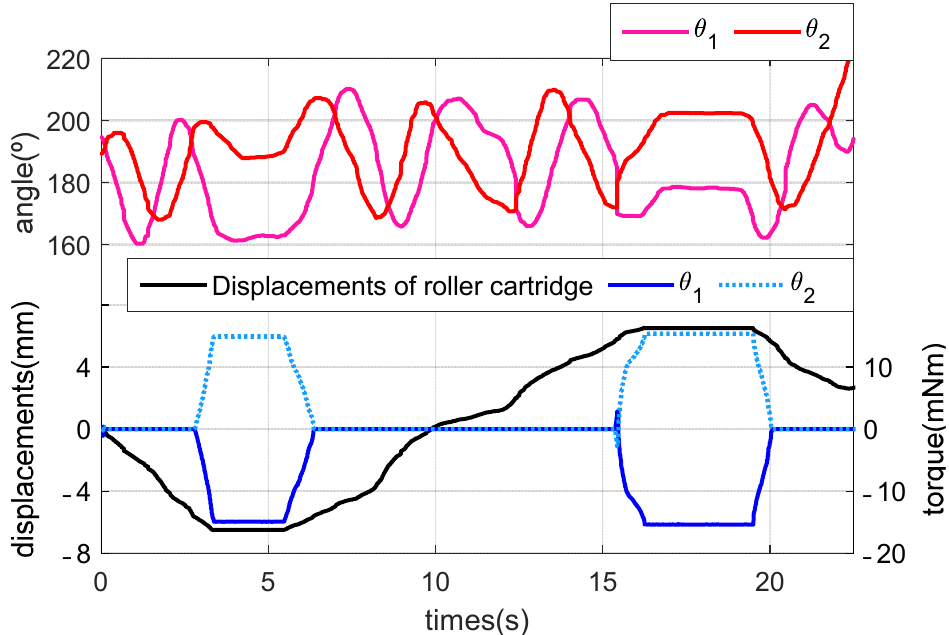
Figure 10. Torques for the haptic feedback depending on the directions of θ 1 , θ 2 , and the position of the roller of the roller cartridge.